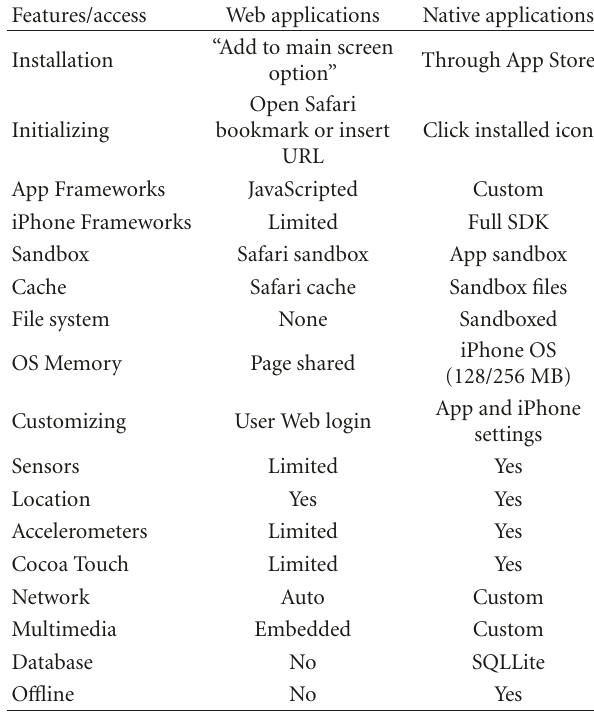
Table 1: Main di ff erences between iPhone Web and native applica- tions.